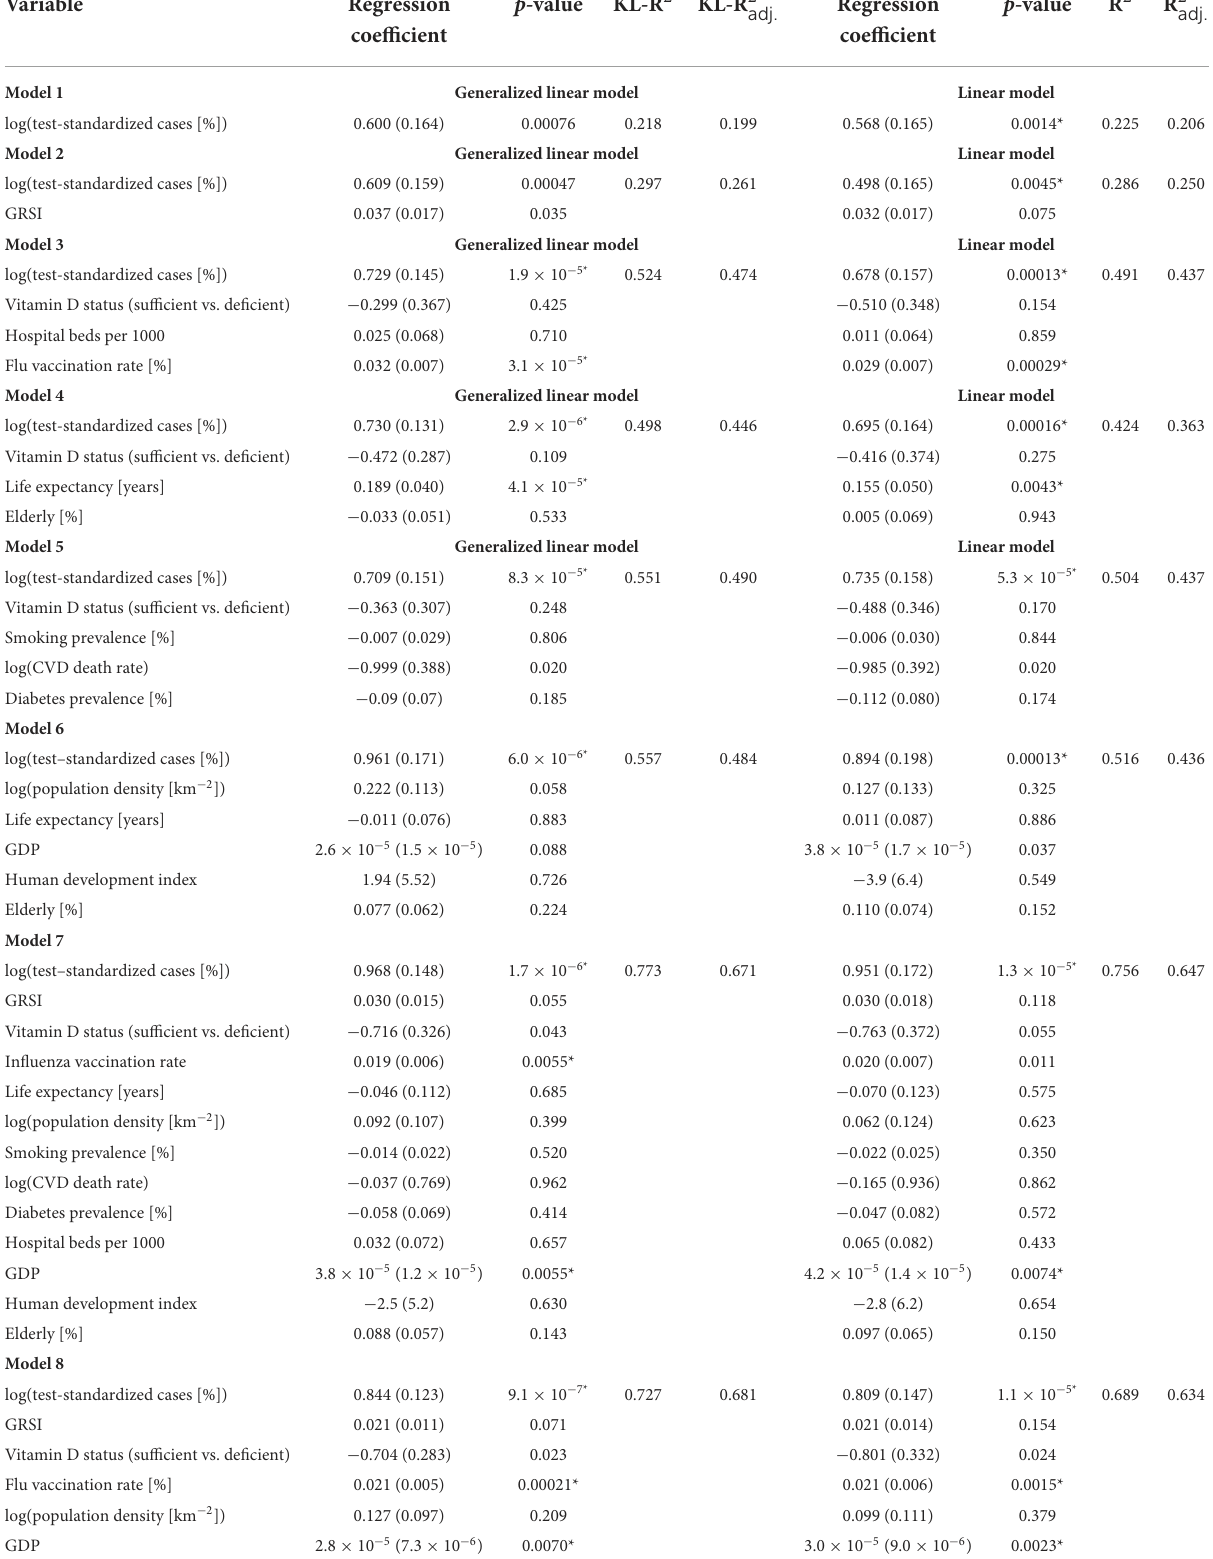
TABLE 1 Parameters of the generalized linear models fitted to standardized deaths and linear models fitted to the logarithm of standardized deaths.